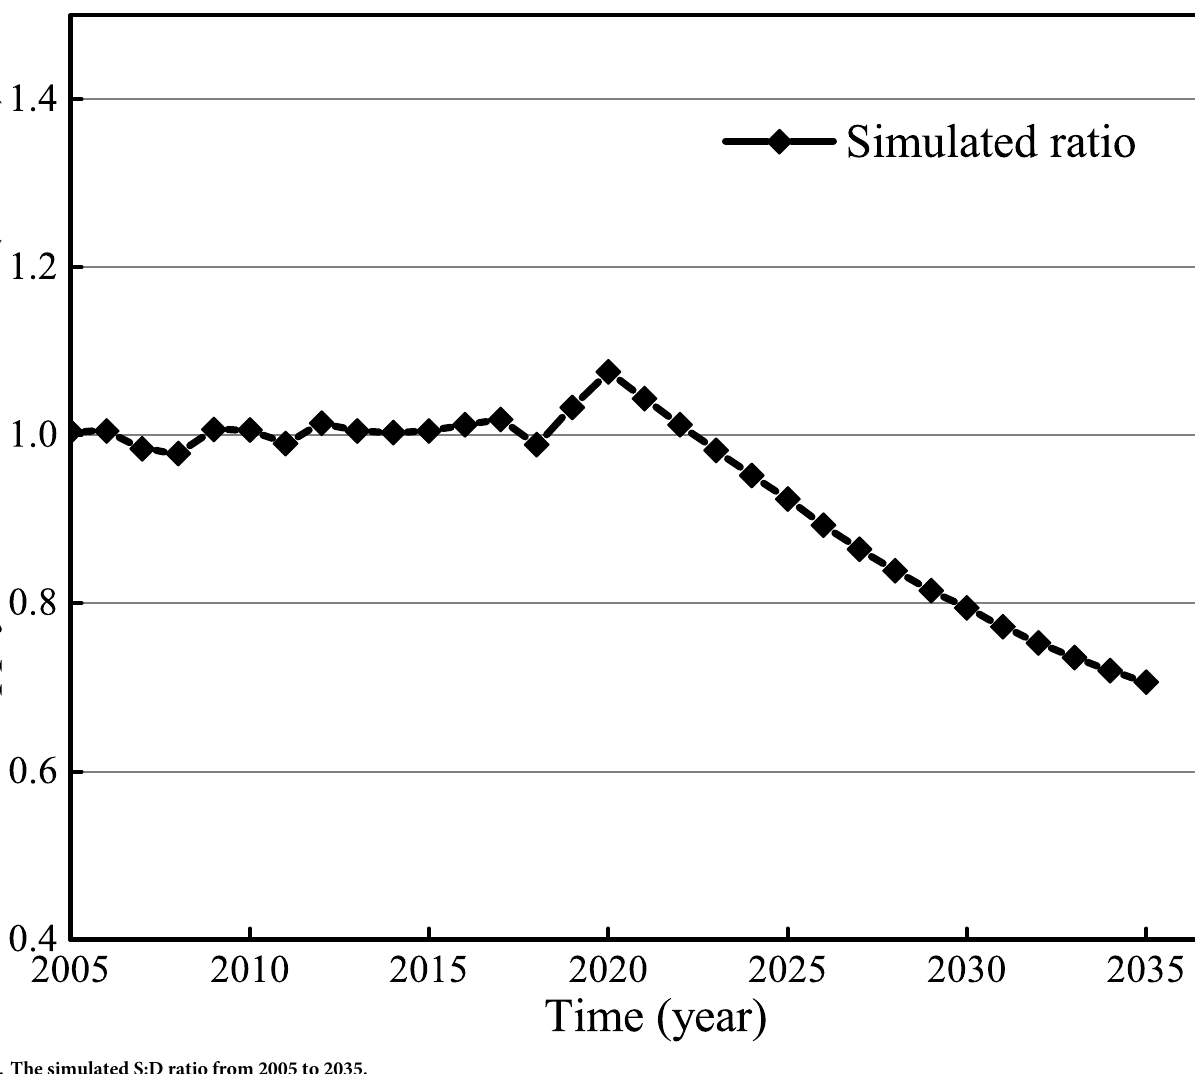
Fig 4. The simulated S:D ratio from 2005 to 2035.